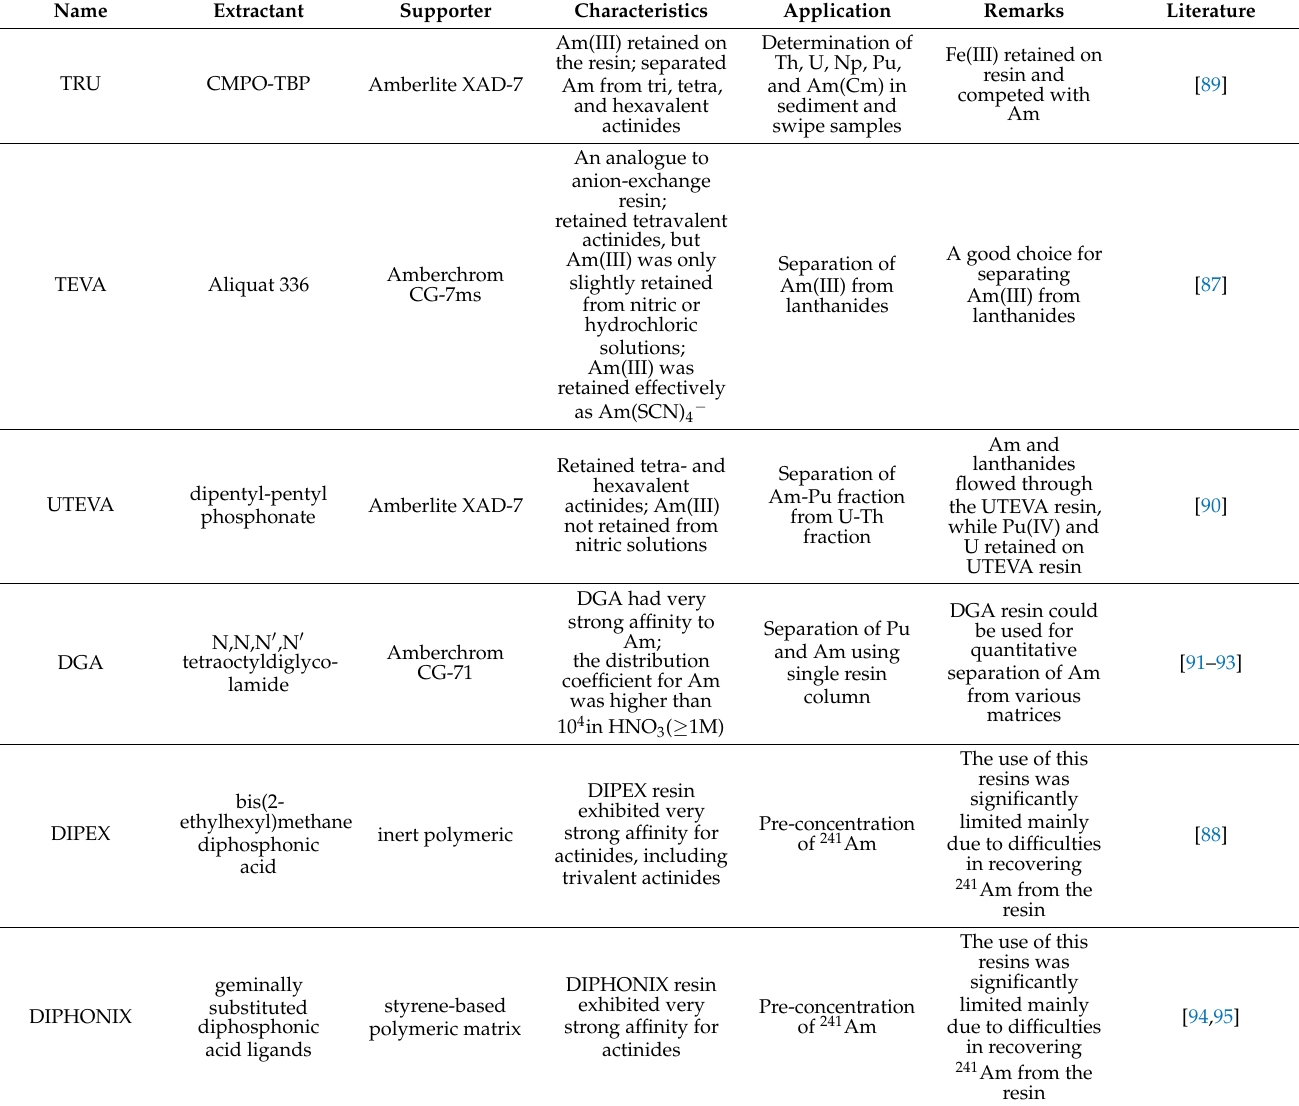
Table 5. The characteristics of different commercial extraction chromatographic